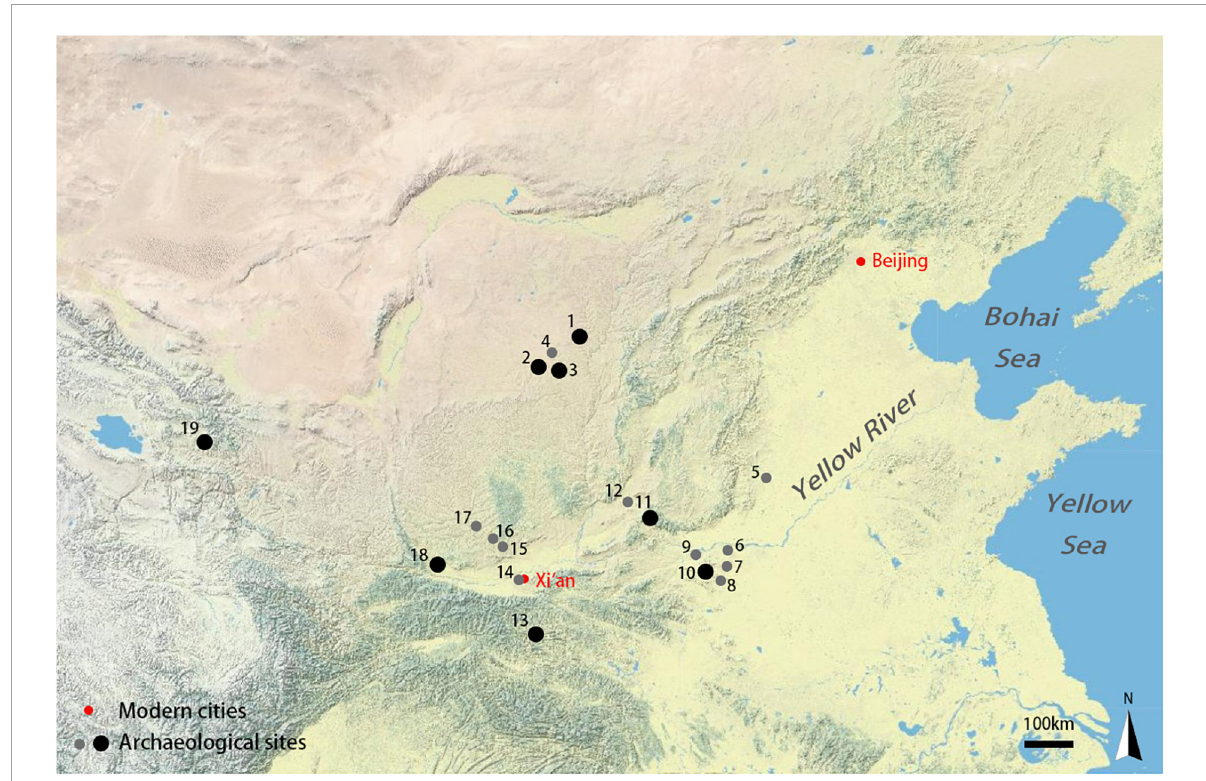
FIGURE1 Map of archeological sites included in this study. 1. Shimao; 2. Muzhuzhuliang; 3. Shengedaliang; 4, Huoshiliang; 5, Xiaomintun locus of Anyang Yinxu, Zhangdeng; 6, Guandimiao; 7, Xinzhai; 8, Wadian; 9, Erlitou; 10, Nanwa, Wangchenggang; 11, Zhoujiazhuang; 12, Taosi; 13, Donglongshan; 14, Fengxi; 15, Zaoshugounao; 16, Zaolinhetan; 17, Nianzipo; 18, Yuntang, Qijia, Zhougongmiao locus of Zhouyuan; 19, Changning.